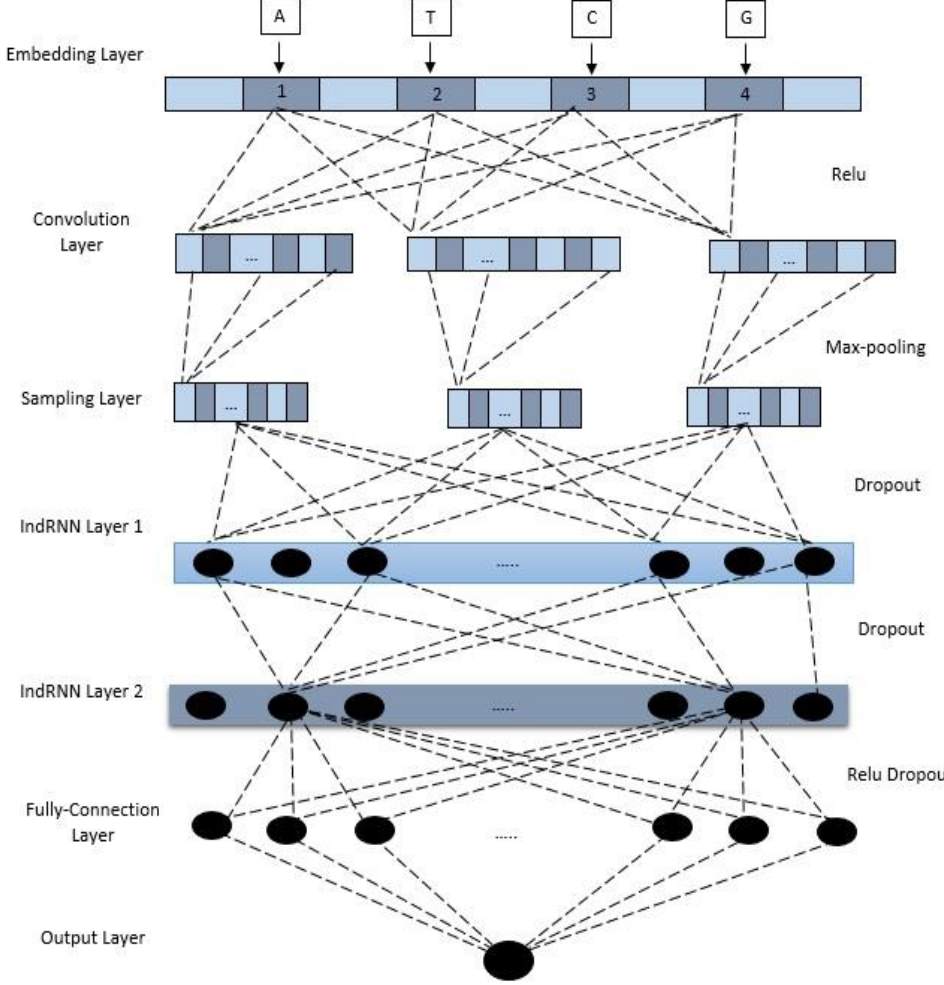
Figure 3. The general architecture of the proposed